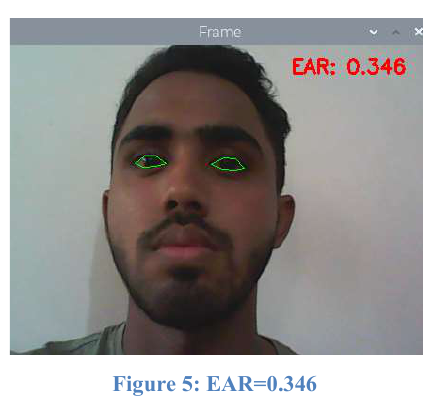
Figure 5: EAR=0.346